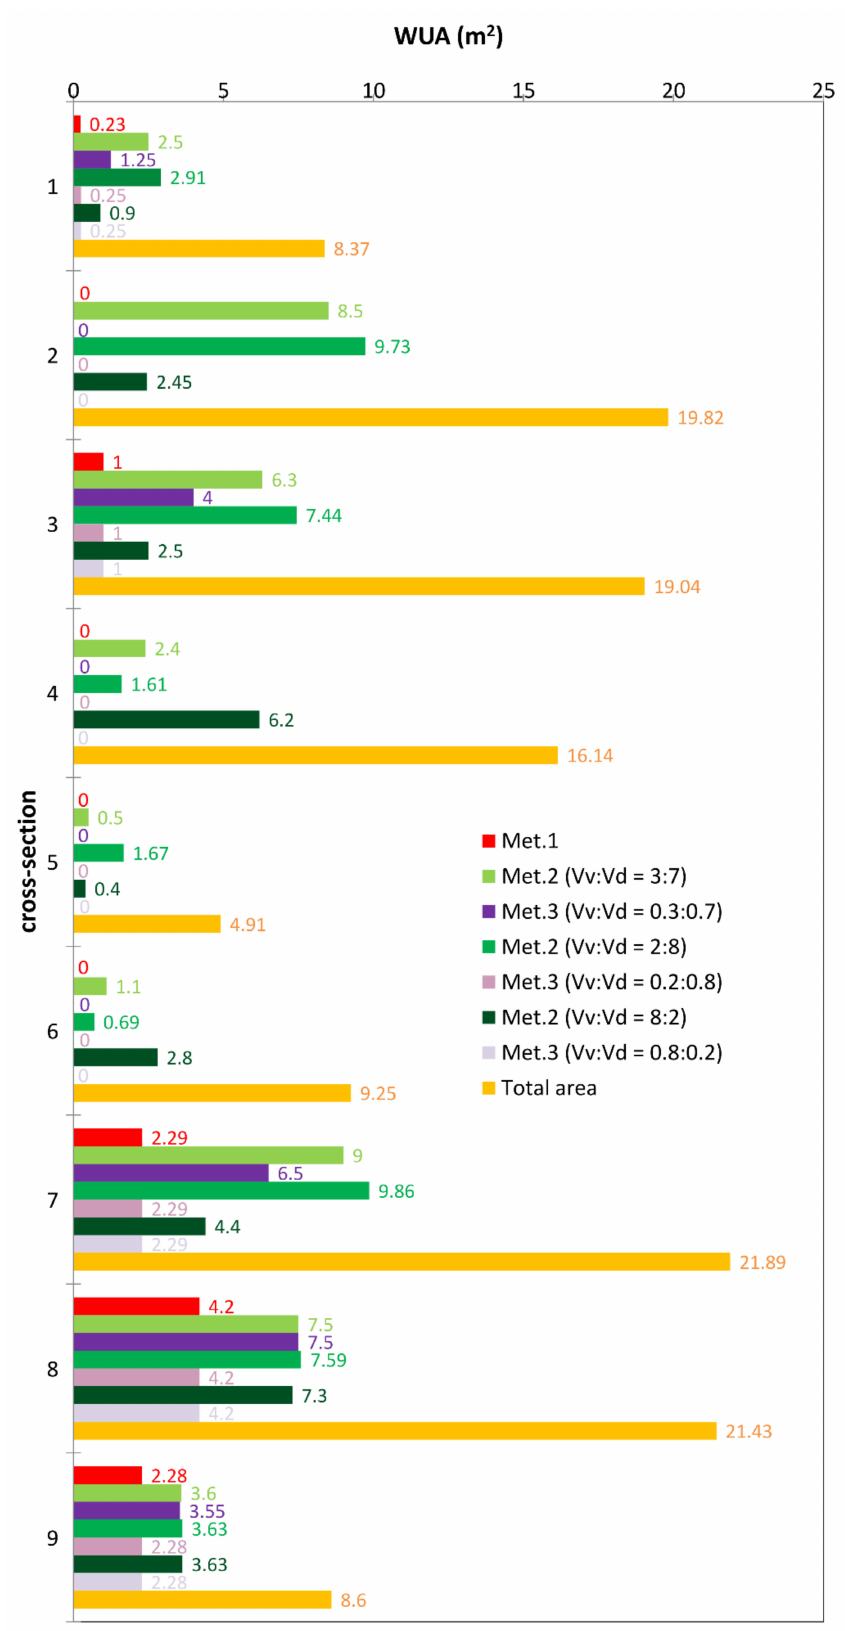
Figure 5. Comparison of the WUA by three methods in individual cross-sections of the Teplica River (values in the histogram are given for Methods 1, 2, and 3; the total area is shown for comparison). Met.: